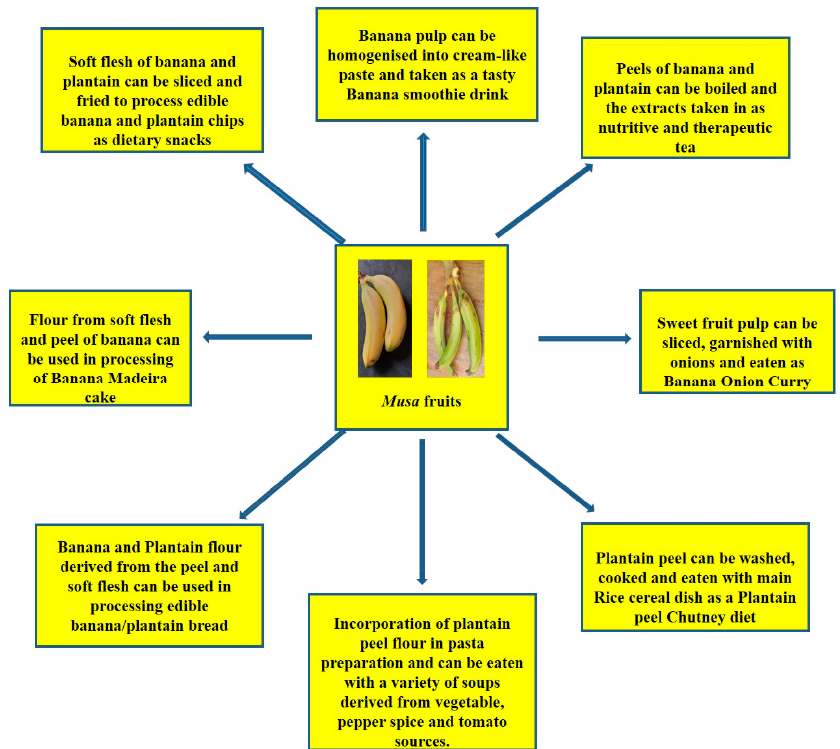
Figure 22. Dietary incorporation of Musa fruit compartments (soft flesh and peel) as contributors to improved diet diversity strategy towards alleviation to micronutrient deficiencies.